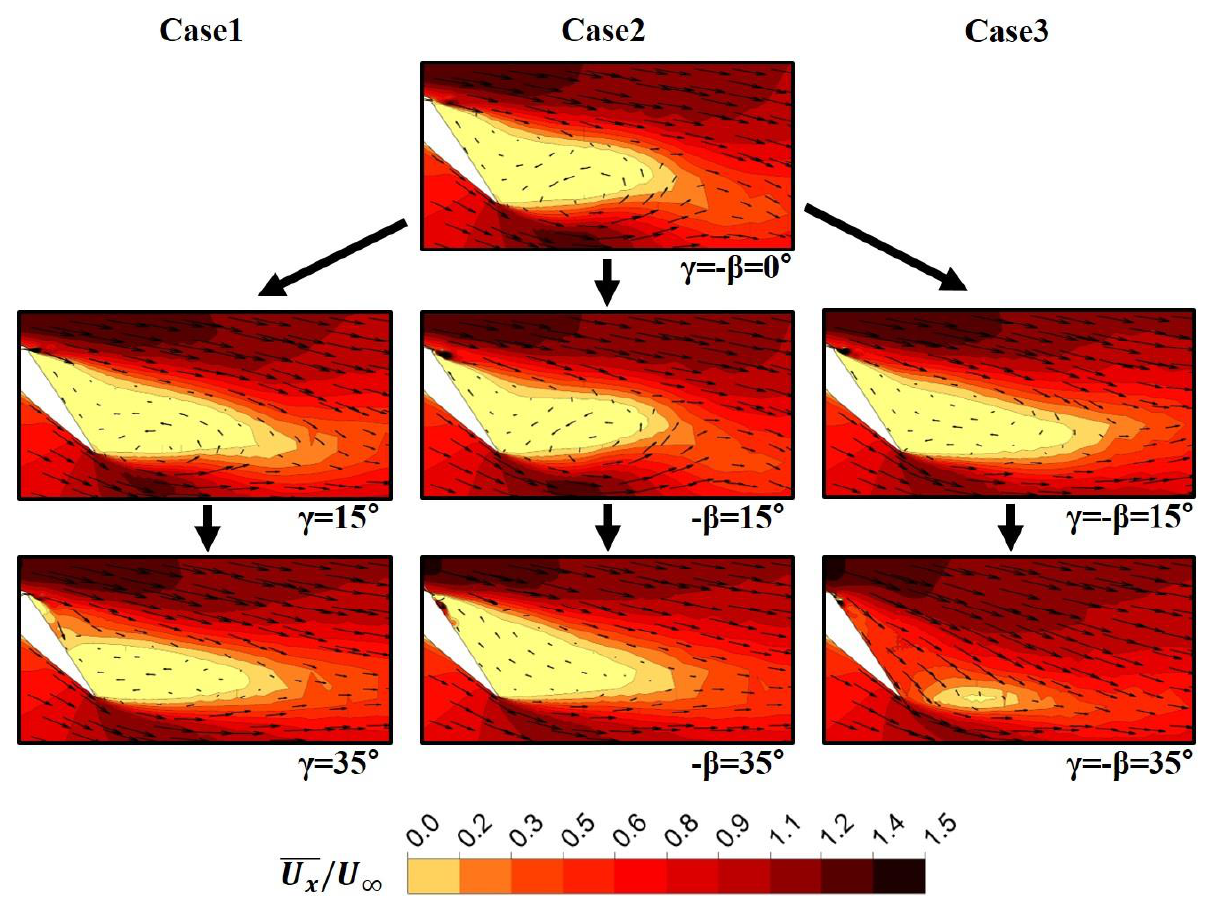
Figure 12. Time-averaged streamwise velocity contours and velocity vectors for different γ and/or − β angles on x-z plane at the center of computational domain (α = 8°, δ f = 40°).